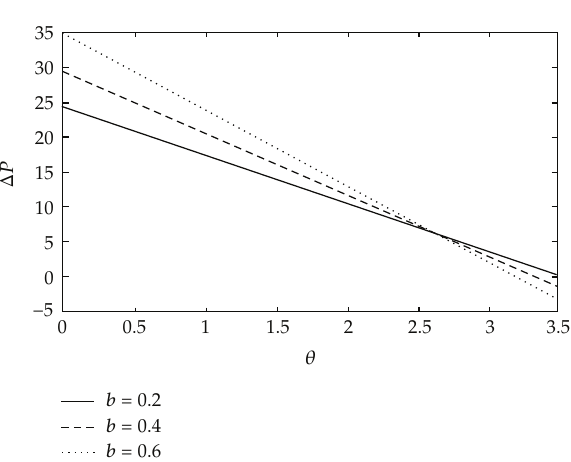
Figure 7: The pressure rise verses flow rate when α (cid:9) 0 . 01 , a (cid:9) 0 . 2, d (cid:9) 0 . 8 , ε (cid:9) 0 . 3 , λ 1 (cid:9) 0 . 4 , Da (cid:9) 0 . 5, and φ (cid:9) π/ 4.